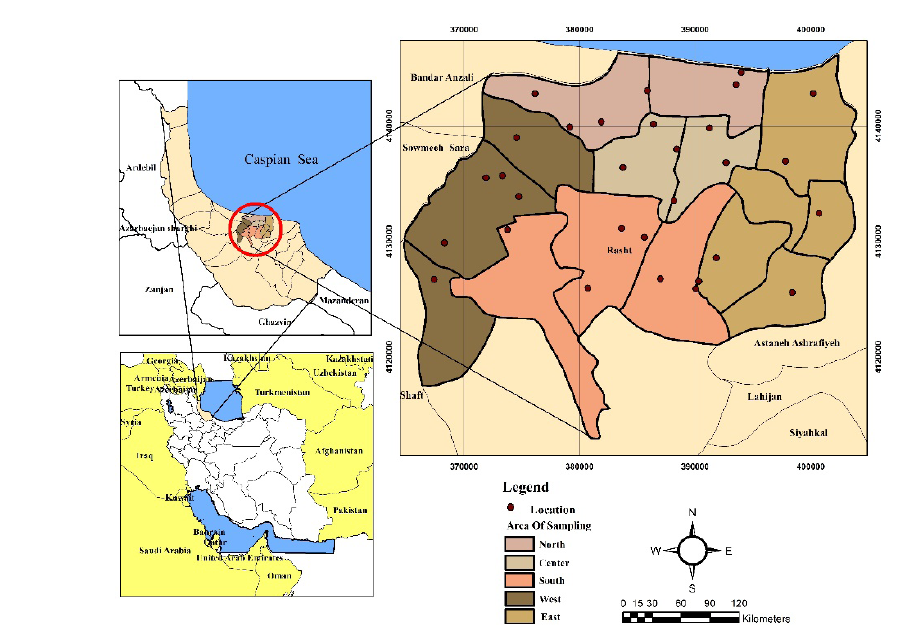
Figure 1. The studied